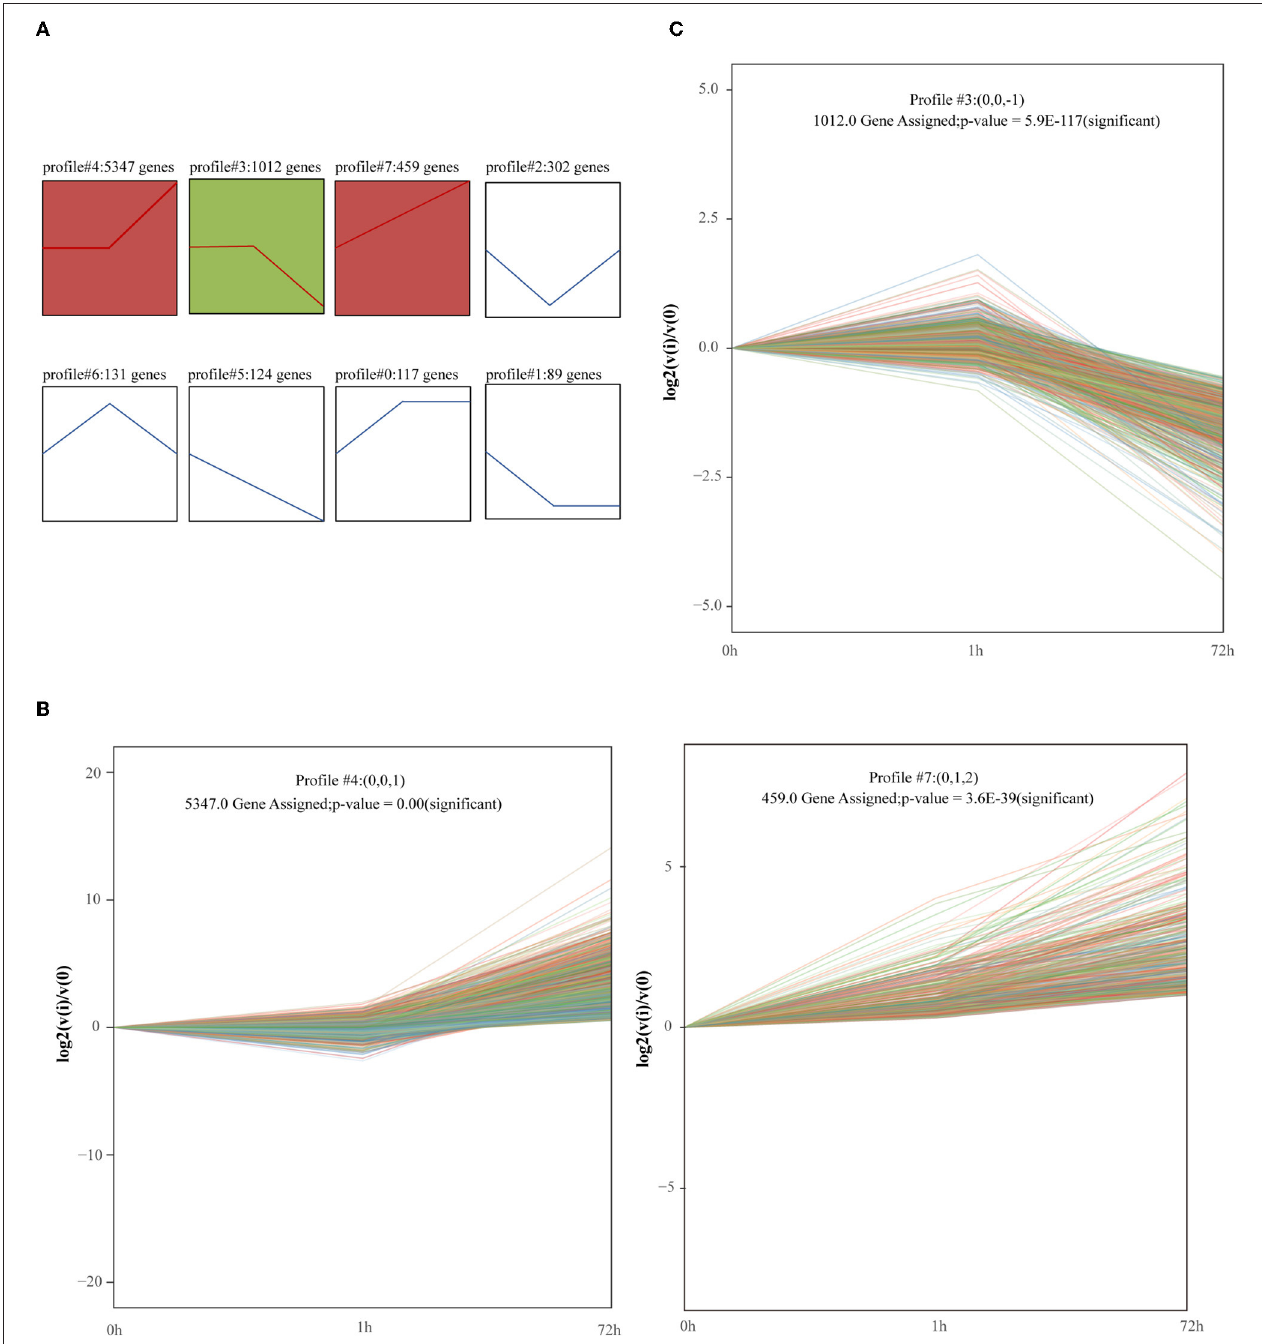
FIGURE 4 | Short Time-Series Expression Miner (STEM) analysis of gene expression profile. Squares of the same color indicate that the correlation is > 0.7. (A) Trend analysis of genes. Gene expression was normalized in the STEM software and genes with maximal values minus minimal values not < 1 were included in the analysis. The 7581 genes from 0, 1, and 72h after MI were clustered into 8 profiles. (B,C) Significantly enriched trend analysis of profile#3, profile#4, and profile#7.